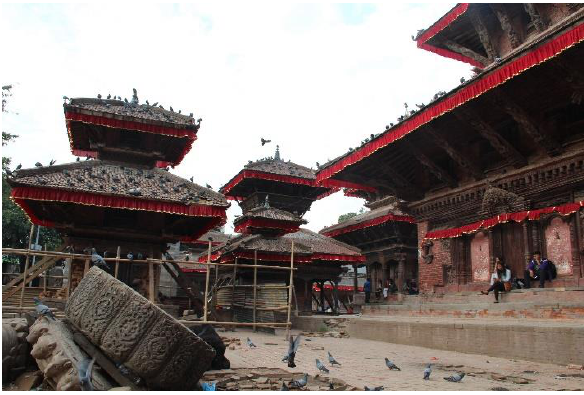
Figure 1. Heritage temples in Kathmandu Durbar